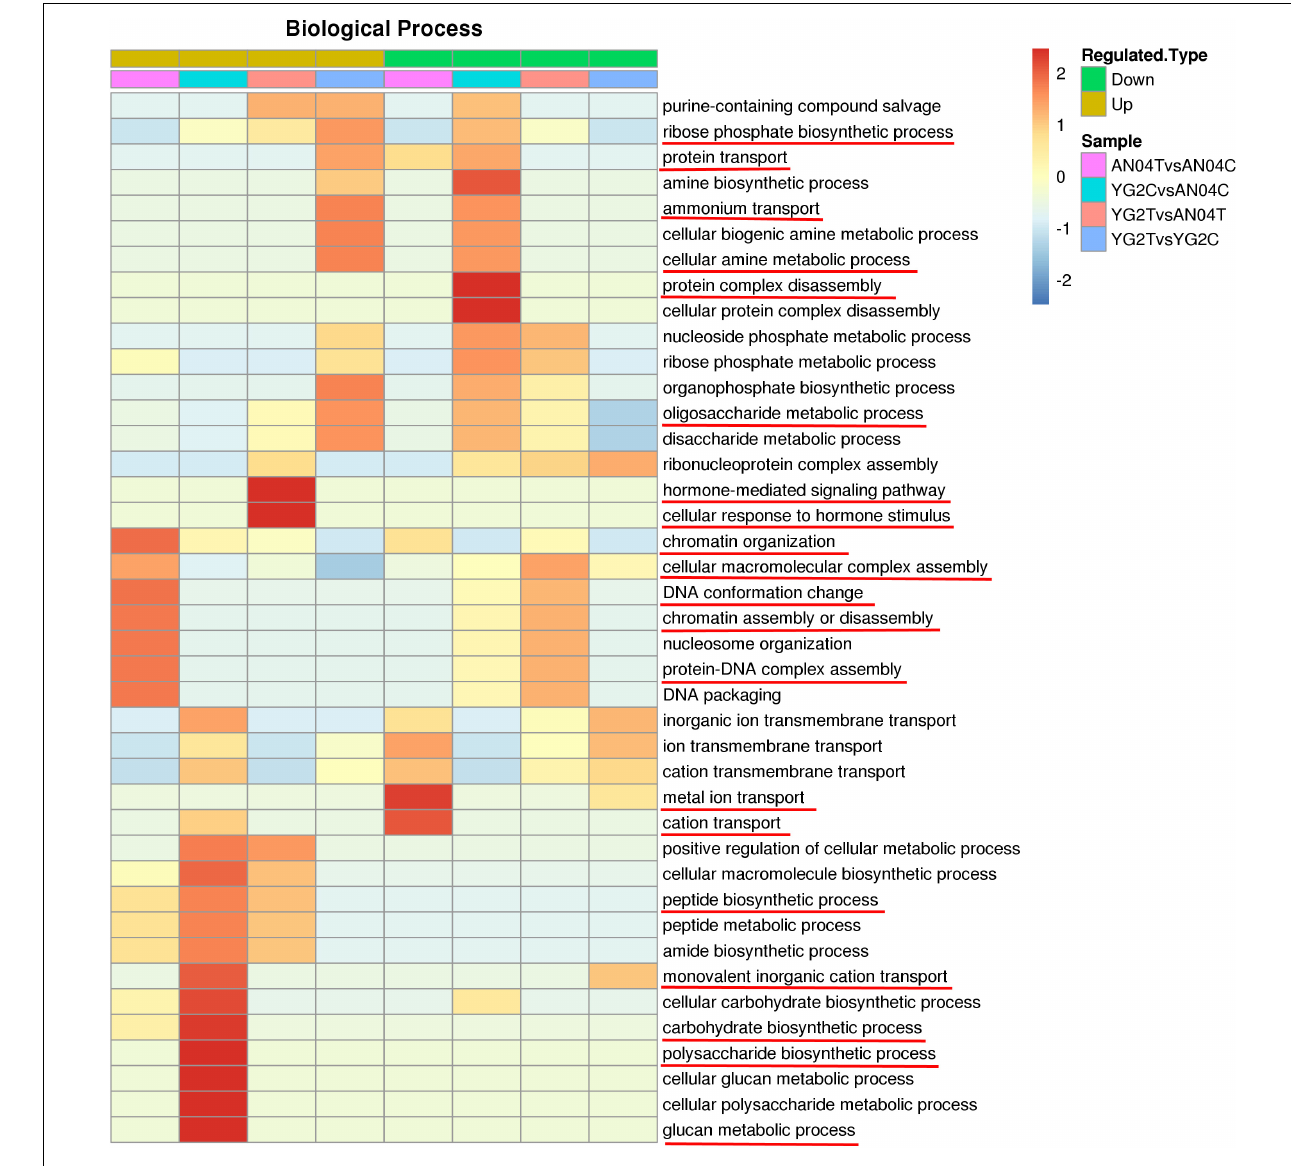
FIGURE 4 | GO functional cluster of DRPPs in the biological process. The key biological processes were marked with red